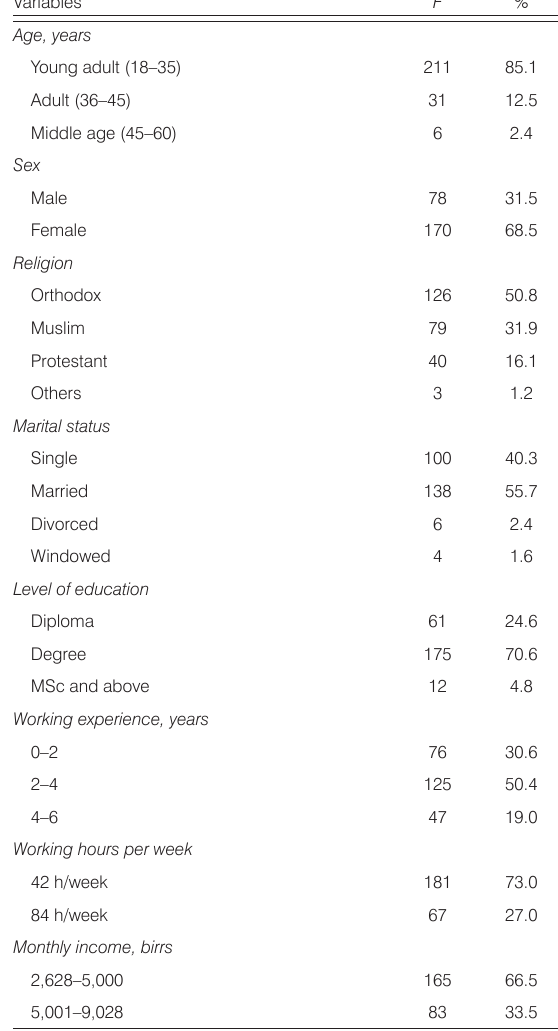
Table 1. Socio-demographic characteristics of the study participants in the study of predictors of moral distress among nurses working at JUMC, South West Ethiopia, April 2019 ( n =